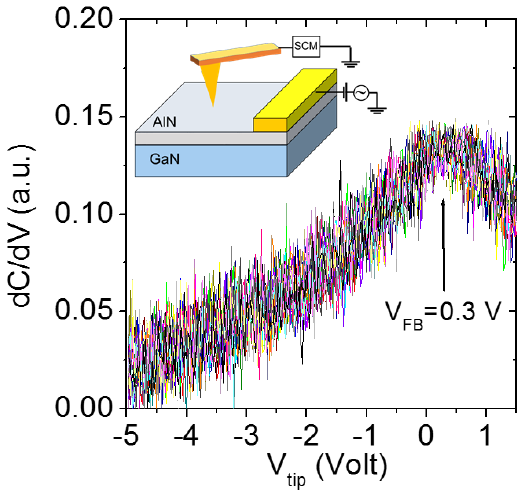
Figure 6. Local dC/dV–V tip curves measured on an array of 5 × 5 positions of the diamond-tip on the AlN surface. The flatband voltage V FB = 0.3V for the diamond tip/AlN/GaN heterostructure is indicated. The experimental configuration for SCM measurements is schematically illustrated in the inset.